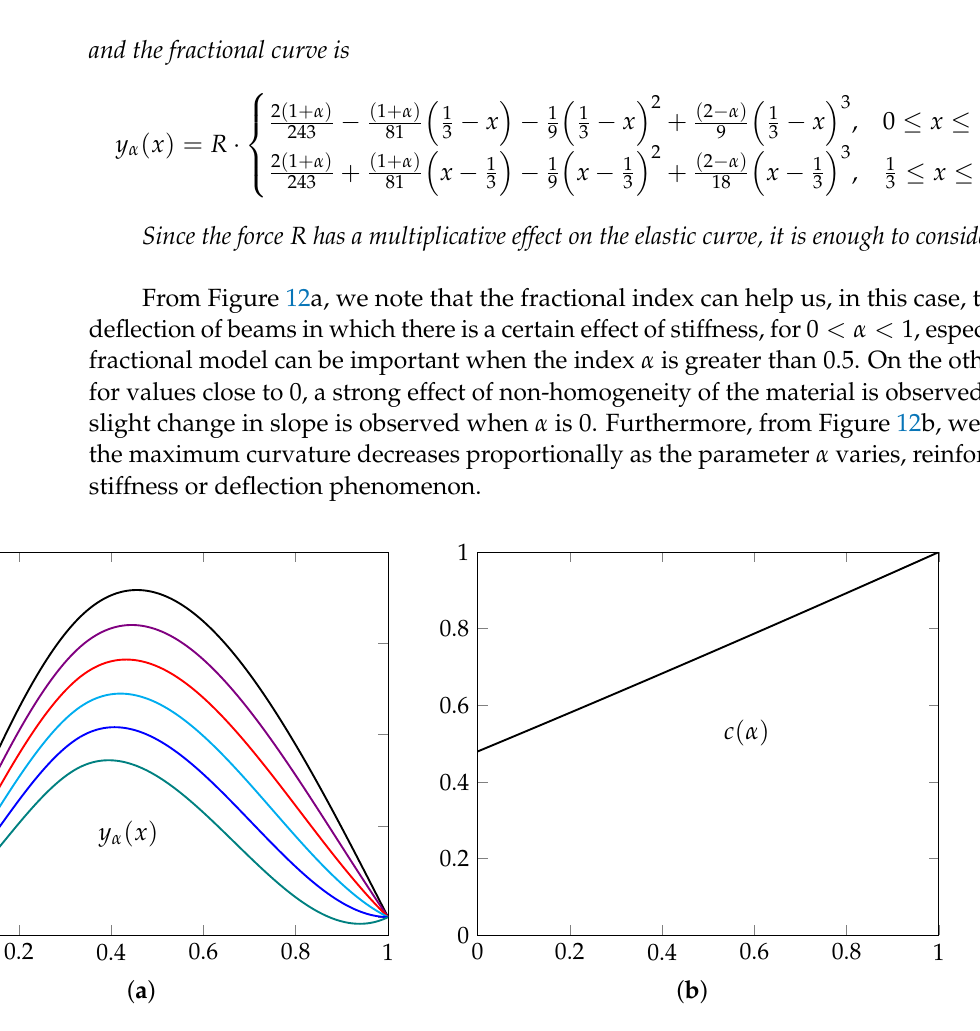
Figure 12. Graphs of Example 8. ( a ) Graph of y α ( x ) given in (23) for α = 0, 0.2, 0.4, 0.6, 0.8, 1. ( b ) Graph of c ( α ) given in